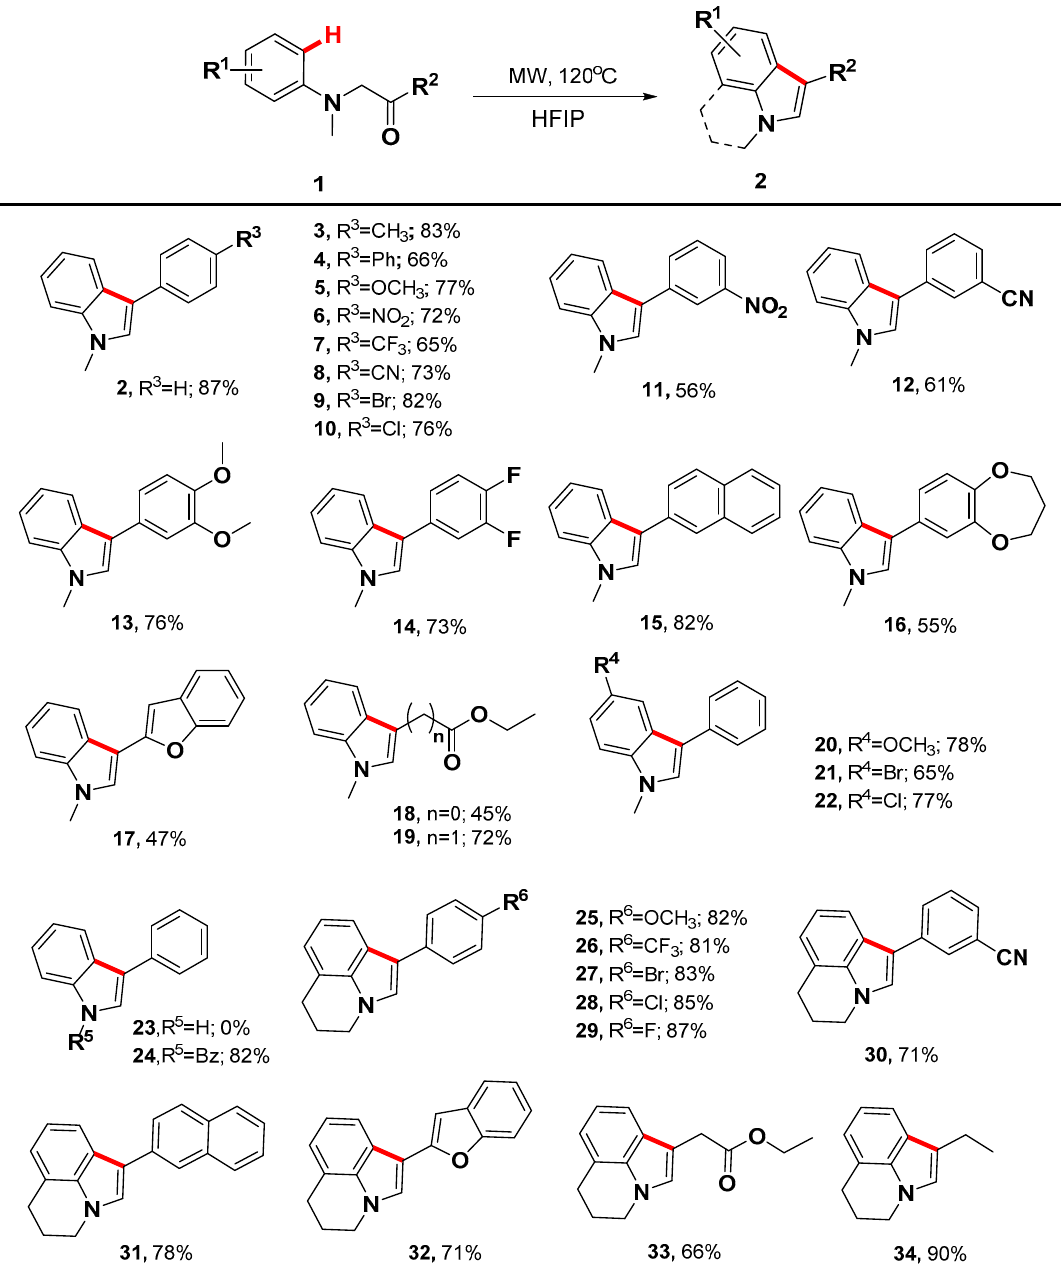
Table 2. HFIP-promoted synthesis of indoles under microwave irradiation a .